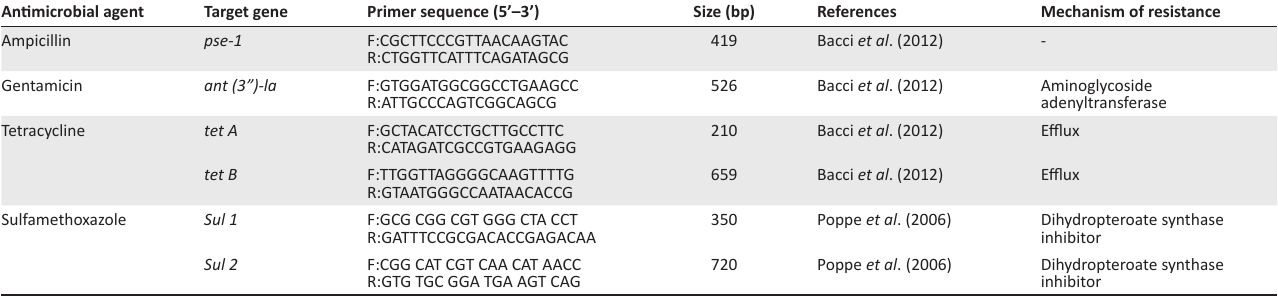
TABLE 3: Primers used to screen antimicrobial resistance genes in Salmonella spp. Antimicrobial